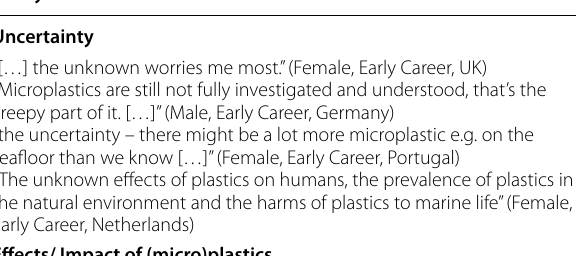
Table 4 Open-ended answers selected to illustrate responses to “If you have indicated that you are worried for any of the above, please briefly state what impacts you are specifically worried